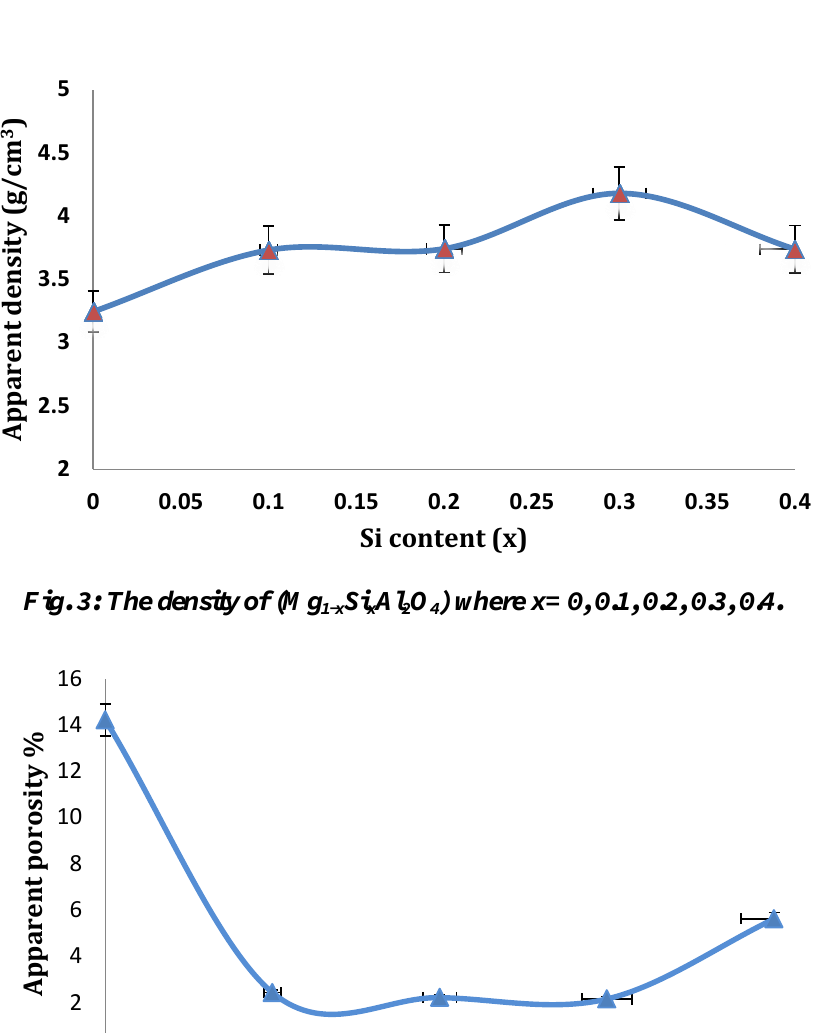
Si Al O ) where x=0, 0.1, 0.2, 0.3, 0.4. 1-x x 2 4